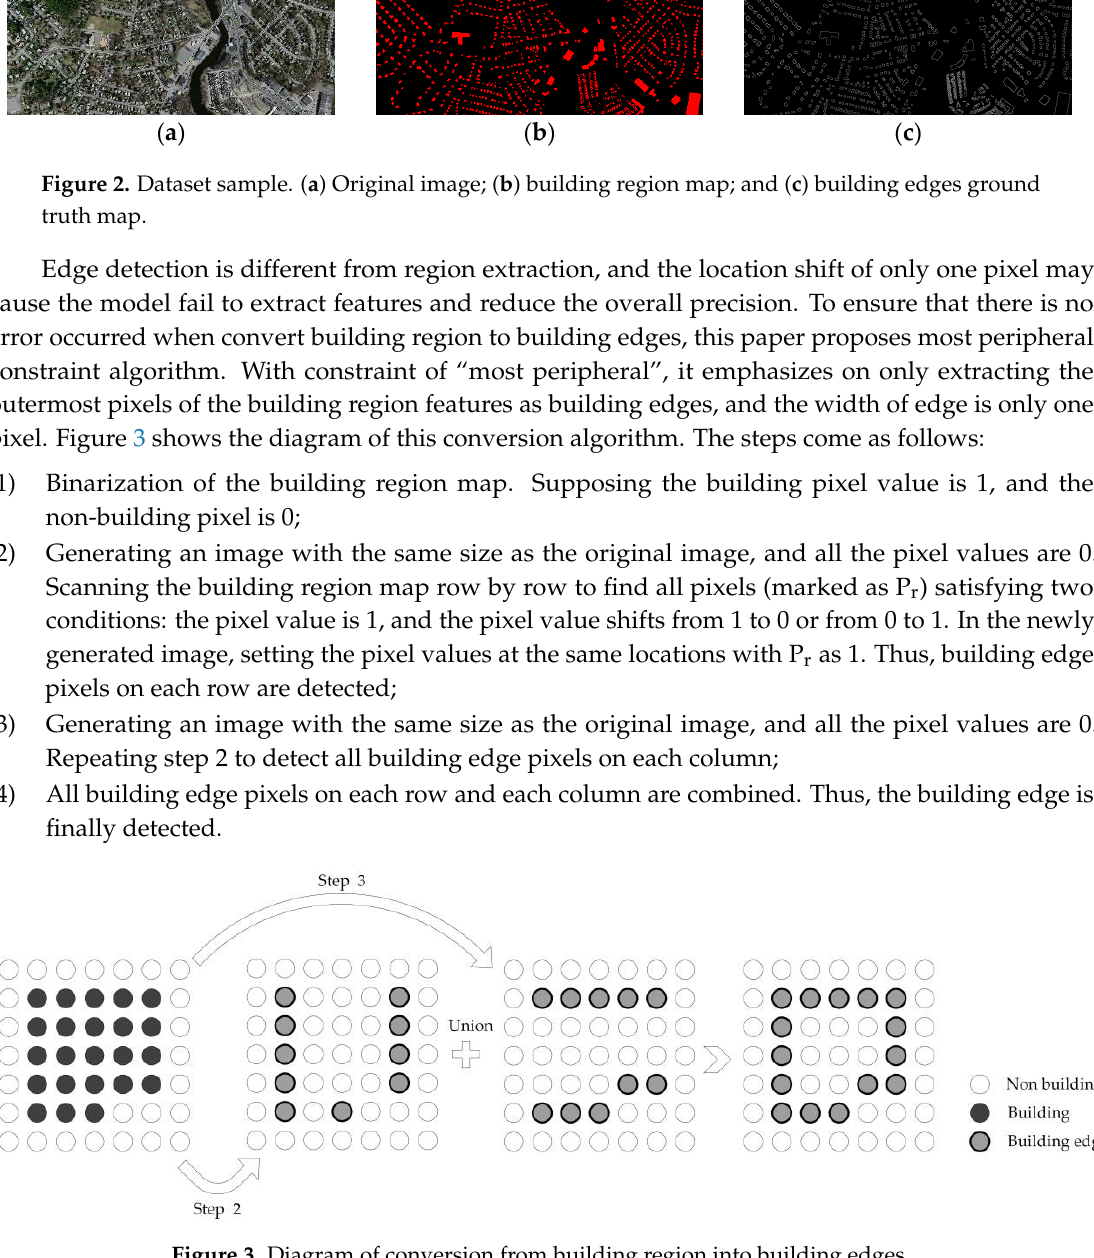
Figure 3. Diagram of conversion from building region into building edges.